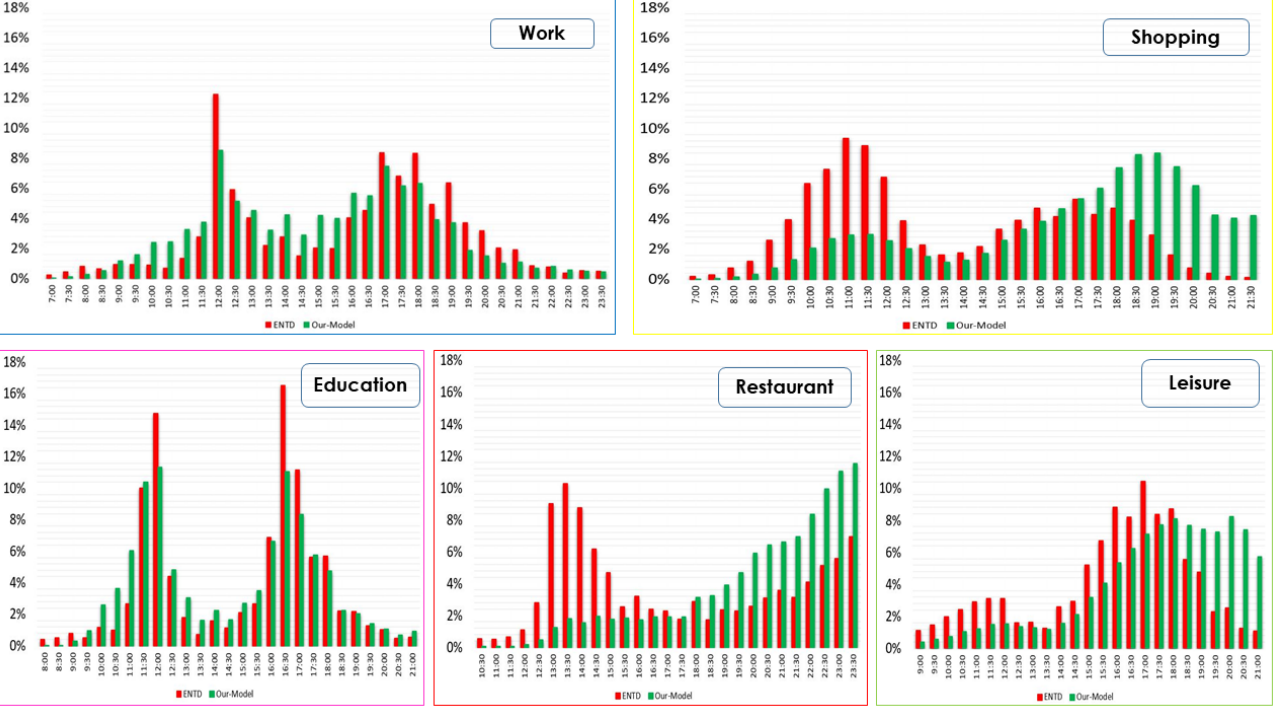
Figure 28. Activity end-time: a comparison of end-time distributions between ENTD (red) and the proposed model (green). Work and education have similar distributions to those of ENTD. Shopping and leisure have some differences in the distributions (due the region and the time of year). Restaurant-activity has two peaks (midday and evening) at ENTD, representing lunch and dinner, while in the proposed model, only the dinner is